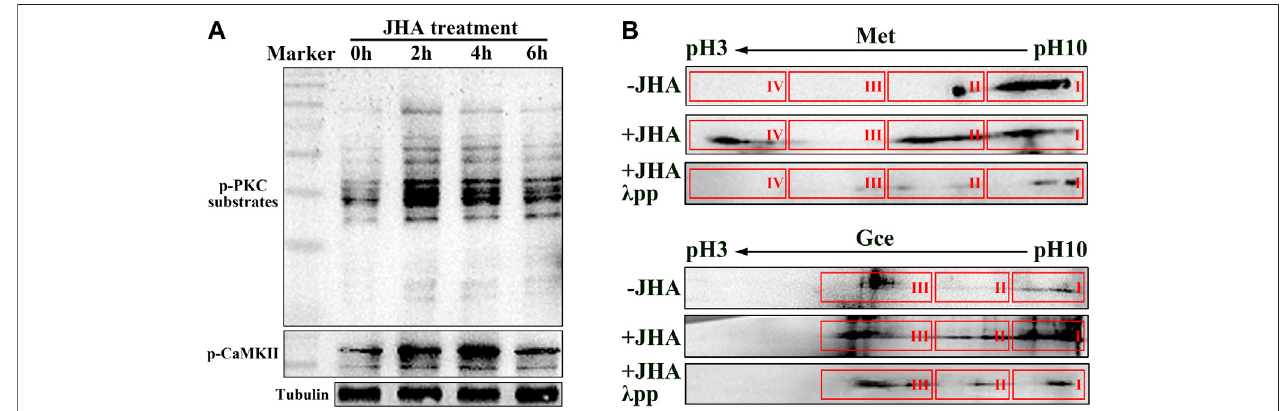
FIGURE 1 | Phosphorylation of Met and Gce in Drosophila Kc cells induced by Methoprene (JHA). (A) Phosphorylated PKC substrate and CaMKII levels in response to JHA treatment at various timepoints. The tubulin protein was used as a loading control. (B) Validation of phosphorylated Met and Gce by 2D gel electrophoresis followed by western blot analysis. Met and Gce were visualized by antibodies against